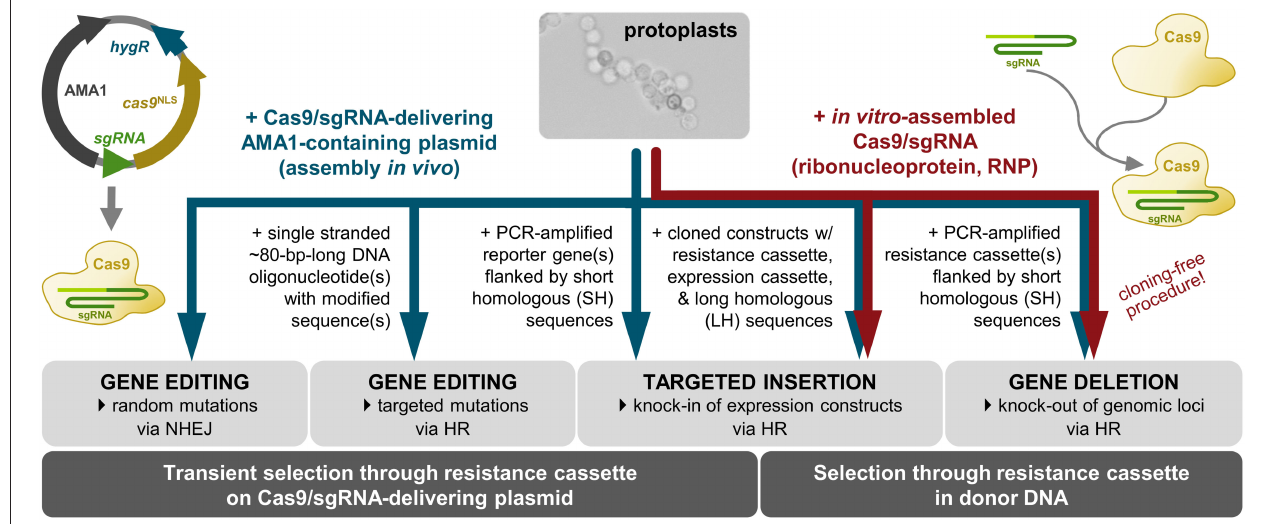
FIGURE 1 | CRISPR/Cas9 applications for targeted modification of the K. petricola genome. The use of AMA1-containing plasmids for expression of Cas9 and target-specific sgRNA ( Nødvig et al., 2015, 2018) enables the generation of marker-free mutants when transient selection is applied on the plasmid-encoded hygromycin (HYG) resistance. The insertion of double strand breaks (DSBs) in specific DNA sequences results in random mutations via non-homologous end-joining (NHEJ) or in targeted mutations when modified single stranded oligonucleotide(s) are provided as repair templates for homologous recombination (HR). By co-transformation of Cas9/sgRNA-delivering plasmids with PCR-generated or cloned constructs (donor DNA) consisting of resistance (and expression) cassettes flanked by homologous sequences, sequences in the genome can be replaced (knock-out) or sequences can be integrated at defined genomic loci (knock-in). The co-transformation of protoplasts with pre-assembled ribonucleoproteins (RNPs) of in vitro -synthesized target-specific sgRNA and purified Cas9 functions together with resistance cassette-containing donor DNA. Combinations of RNPs with PCR-amplified donor DNA (resistance cassette with primer-generated 75-bp-long homologous sequences) enable the cloning-free generation of gene replacement (KO) mutants (Voigt et al., 2020) (this